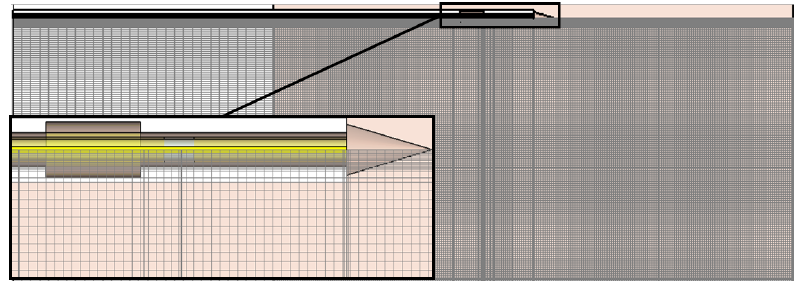
Figure 3. Drawing of the mesh of the simulated region. Local mesh properties were set to the applicator components to resolve small dimensions within the relatively large simulation